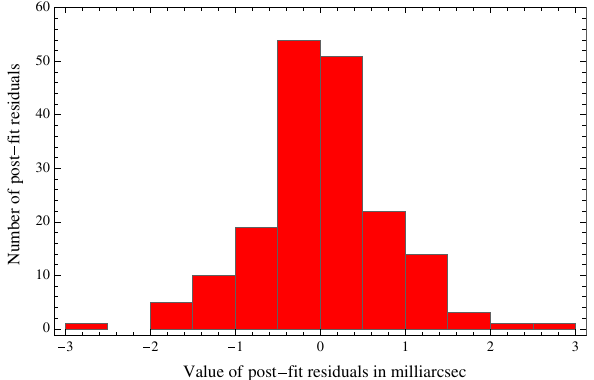
Fig. 5 Distribution of the post-fit combined residuals of LARES, LAGEOS and LAGEOS 2, over about 7 years of orbital observations. In the horizontal axis is the difference in milliarcsec of the residual of each arc, from the mean of the combined residuals. In the vertical axis is number of such combined residuals falling into each 0.5 milliarcsec bin. Here we have removed from the combined residuals the five main tidal signals (and the mean of the combined residuals). The distribution well approximates a Gaussian normal distribution, and supports the estimate of 2% accuracy determined by propagating the uncertainties of GGM05S combined with other smaller errors